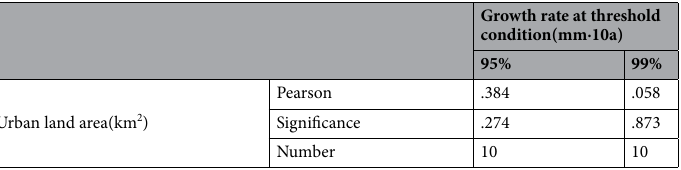
Table 9. Pearson correlation analysis of mean urbanization intensity versus average annual extreme precipitation for 5 periods. ‘‘**’’indicates significant correlation with 0.01 significant level; ‘‘*’’ indicates significant correlation with 0.05 significant level; No labeling indicates that the correlation is not